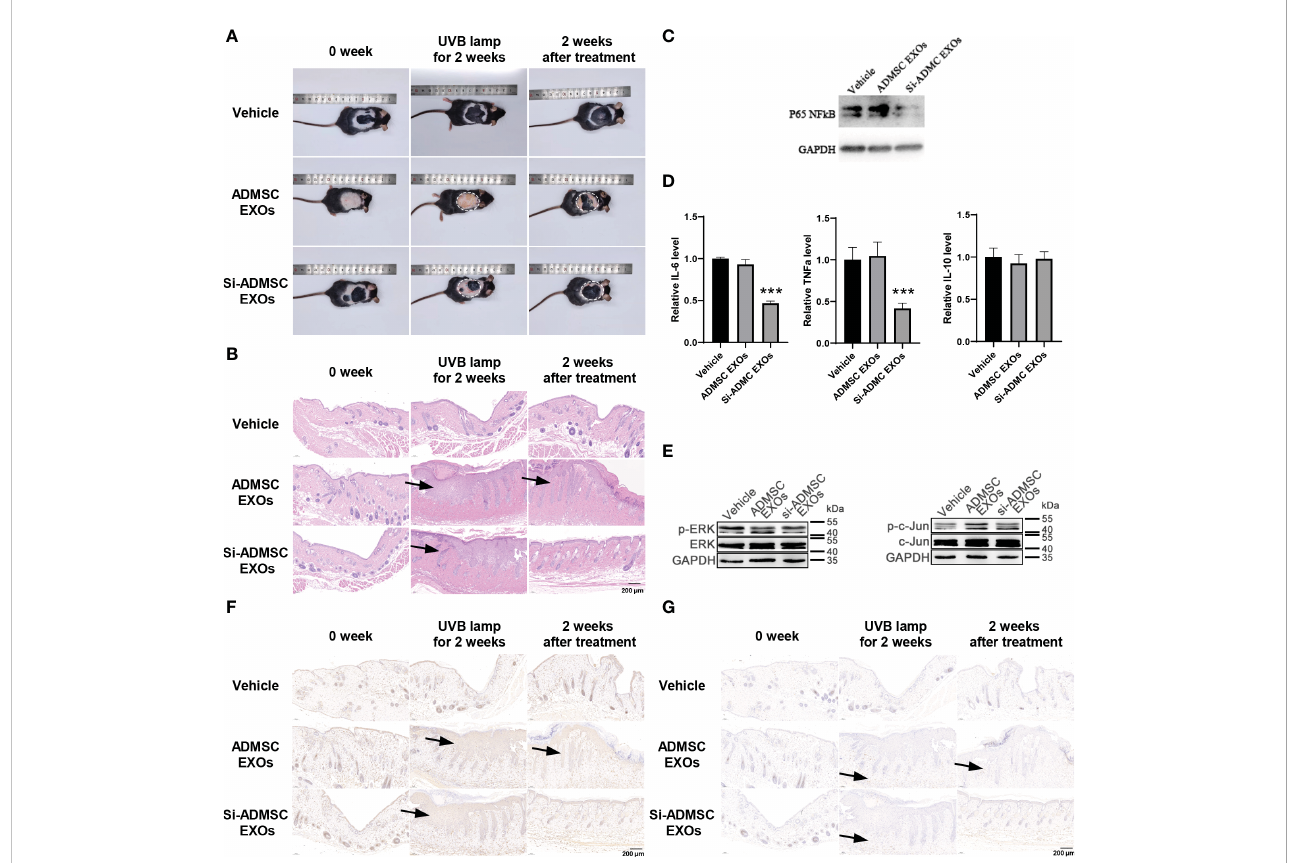
FIGURE 4 In vivo therapeutic effects of engineered si-ADMSC-EXOs in skin injury mice model. (A) Representative macroscopic features of skin injury. The skin injury model in C57BL/6 mice were constructed by two weeks of UV irradiation and then treated by smearing ADMSC-EXOs or si-ADMSC-EXOs exosomes; while control mice were set without UV irradiation (vehicle). (B) Representative images of H&E staining of mice skin injury tissues. (C) The protein level of NF- k B in the treated skin tissues. (D) ELISA assay of IL-6, TNF- a and IL-10 level in the treated skin tissues. (E) The protein level of phosphorylated ERK protein (p-ERK) and c-Jun protein (p-c-Jun) in the treated skin tissues. (F, G) Immunohistochemical analysis of the macrophage markers (F480 and CD206) in the treated skin tissues. *** p